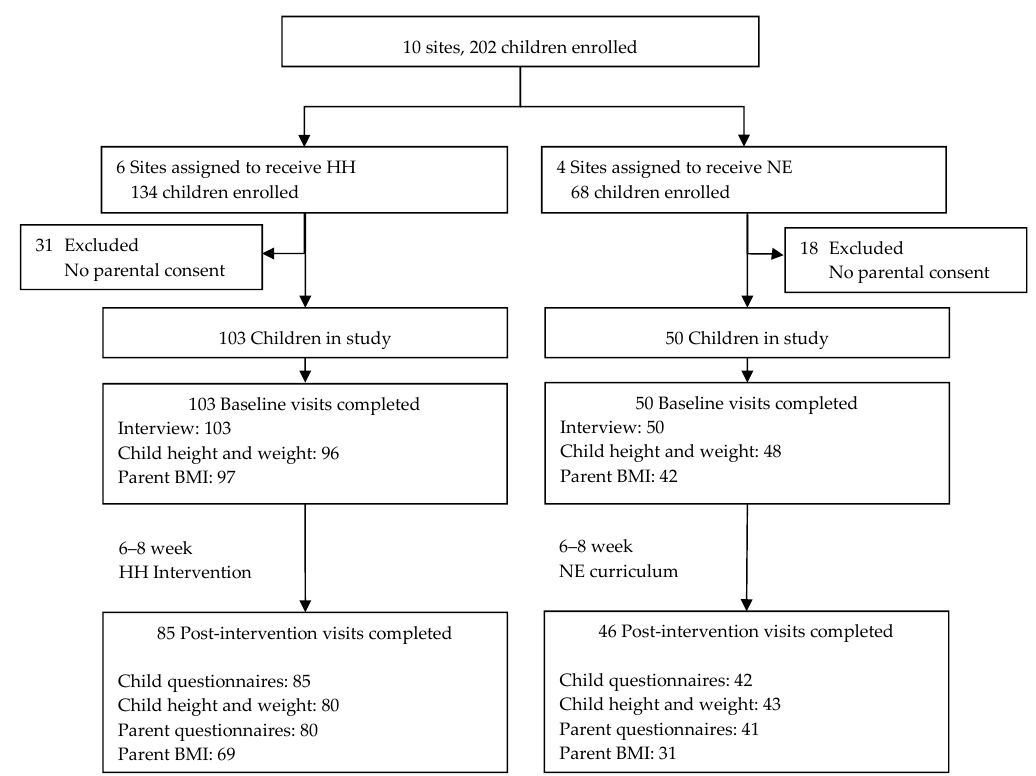
Figure 1. Flow of participants throughout the study.